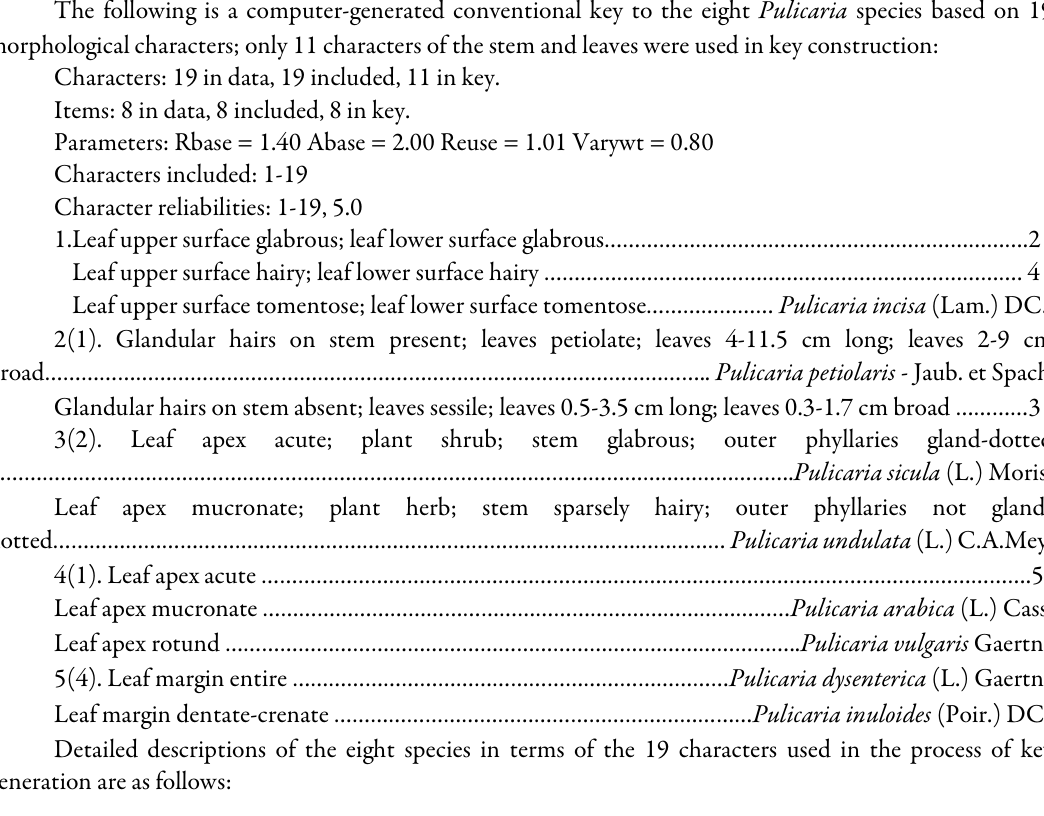
Glandular hairs on stem absent; leaves sessile; leaves 0.5-3.5 cm long; leaves 0.3-1.7 cm broad …………3 3(2). Leaf apex acute; plant shrub; stem glabrous; outer Leaf apex